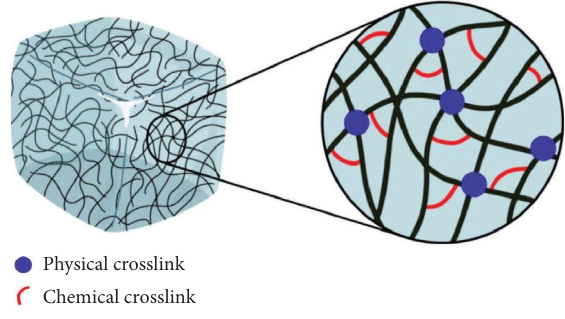
Figure 1: Hydrogel